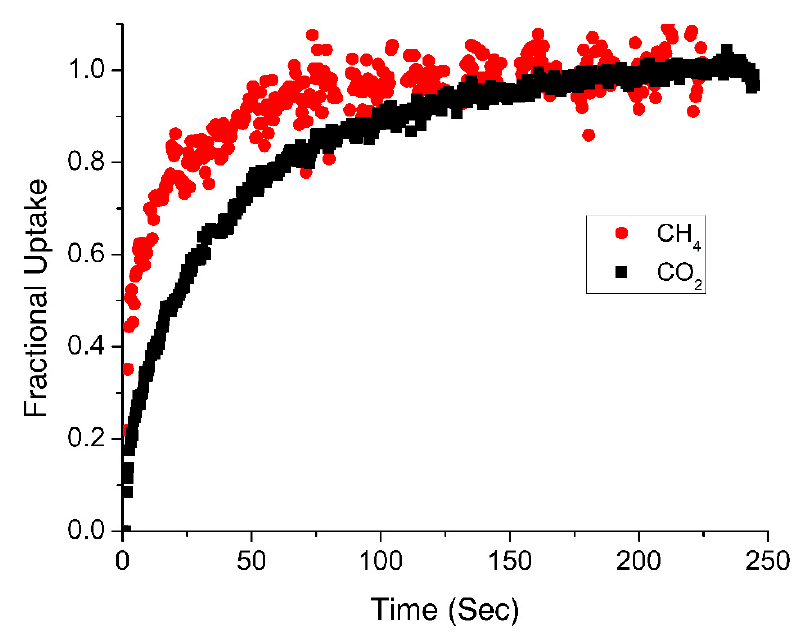
Figure 5. Fractional uptake versus time for the bulk morphology of [Zn 2 (NDC) 2 (DABCO)] n at 273 K for CO 2 and CH 4.